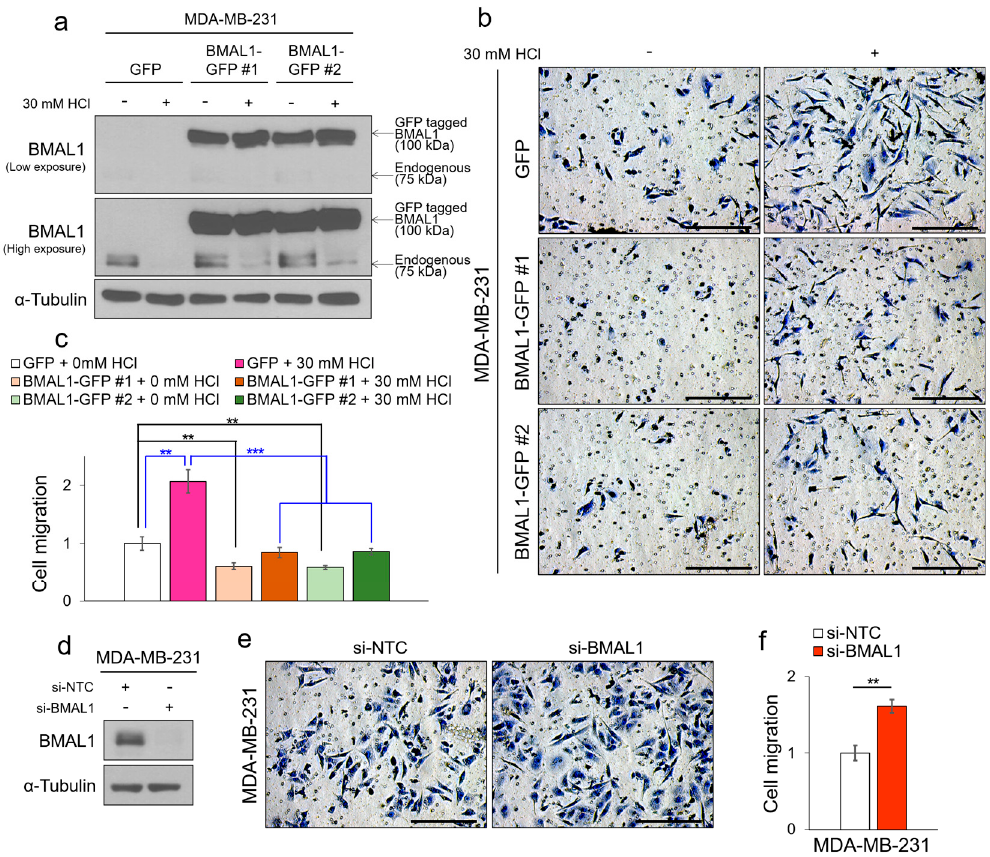
Figure 4. Tumor acidosis-mediated decrease of BMAL1 expression promotes metastatic potency in breast cancer cells. ( a ) The green fluorescent protein (GFP) or GFP-BMAL1 stably overexpressed MDA-MB-231 cell lines were incubated in HCl-mediated acidic condition for 24 h as indicated, and cell lysates were determined by immunoblotting. ( b , c ) GFP or GFP-BMAL1 stably overexpressed MDA-MB-231 cell lines were subjected to trans-well migration assay in HCl-mediated acidic condition for 24 h as indicated. Representative images of migrated cells are shown. Scale bars: 250 µ m ( b ). The average number of migrated GFP or GFP-BMAL1 stably overexpressed MDA-MB-231 cell lines was counted in three random microscopic fields ( c ). ( d ) MDA-MB-231 was transfected with si-NTC or si-BMAL1. Cell lysates were determined by immunoblotting. ( e , f ) MDA-MB-231 was transfected with si-NTC or si-BMAL1, and was subjected to trans-well migration assay for 24 h. Representative images of migrated cells are shown. Scale bars: 250 µ m ( e ). The average number of migrated MDA-MB-231 was counted in three random microscopic fields ( f ). Data represent the mean ± SD, n = 3. ** p < 0.01 and *** p < 0.001 vs. the control group or between two groups by a Student’s t